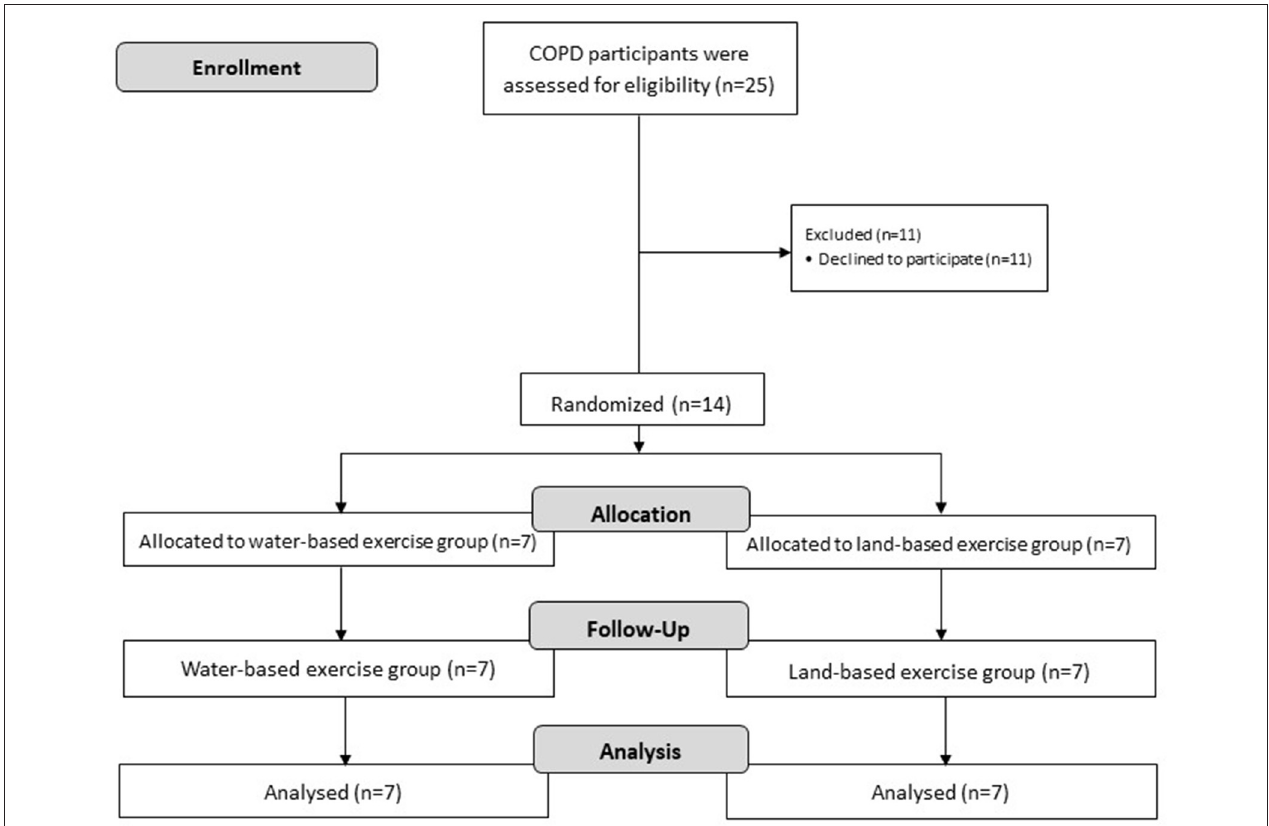
FIGURE 1 | A diagram summarizing the flow of participants through the